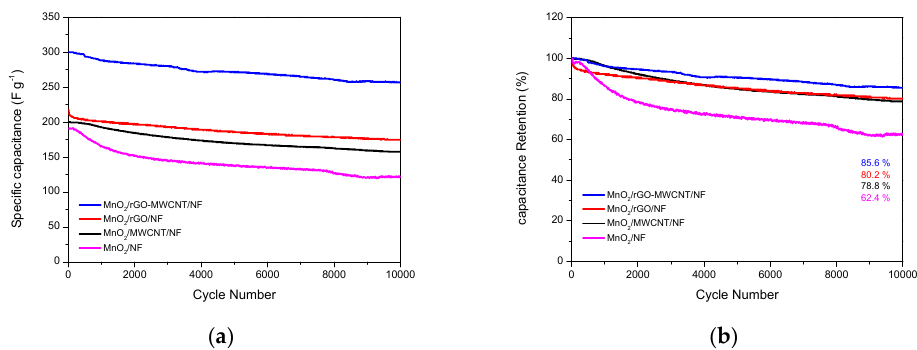
Figure 6. The cycling charge-discharge test for the as-deposited electrodes in a 1 M Na 2 SO 4 electrolyte at a constant current of 4 A·g − 1 . ( a ) Specific capacitance change and ( b ) capacitance retention.